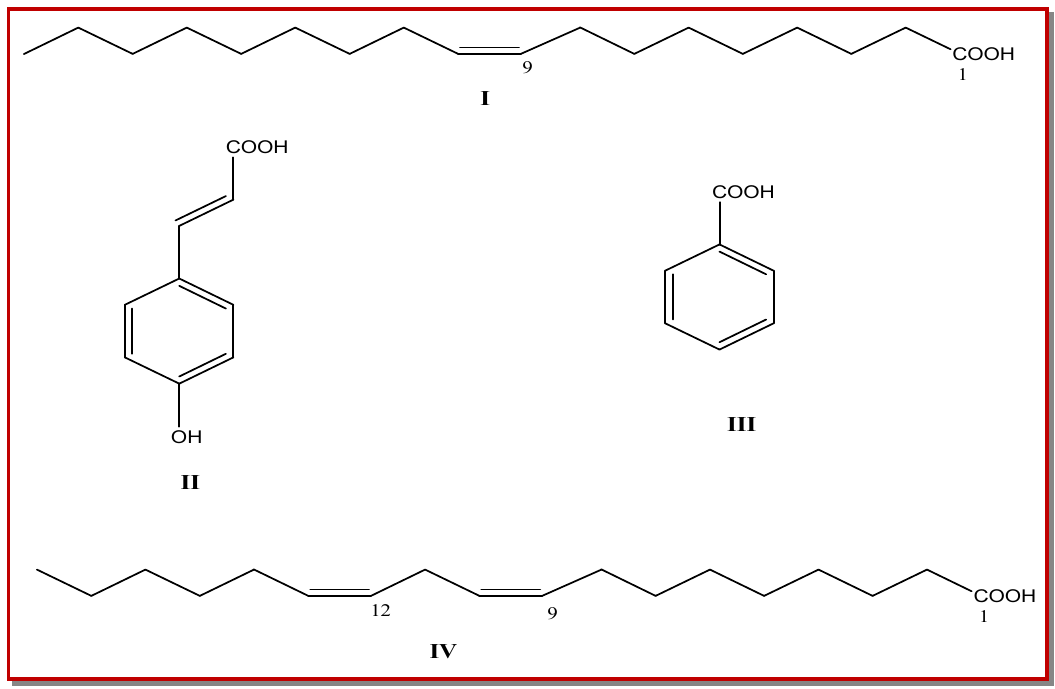
Figure 1: Chemical structure of compounds